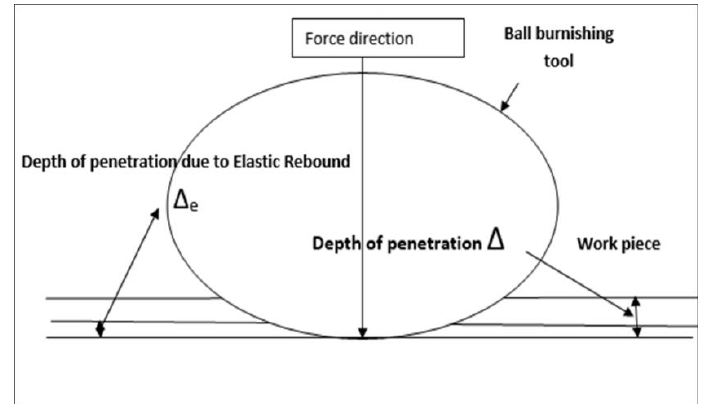
Figure 7. Elastic rebound of material.